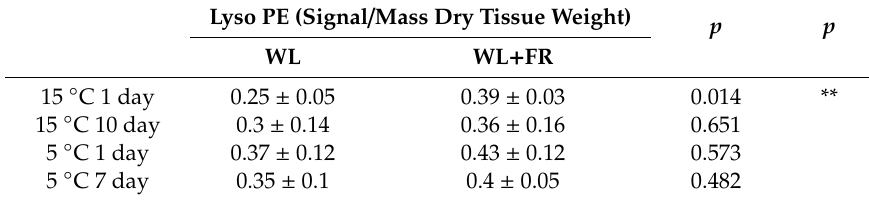
Table 6. Lyso PE in barley leaves grown at 15 ◦ C for 1 and 10 days and in leaves grown at 5 ◦ C for 1 and 7 days under WL and WL +